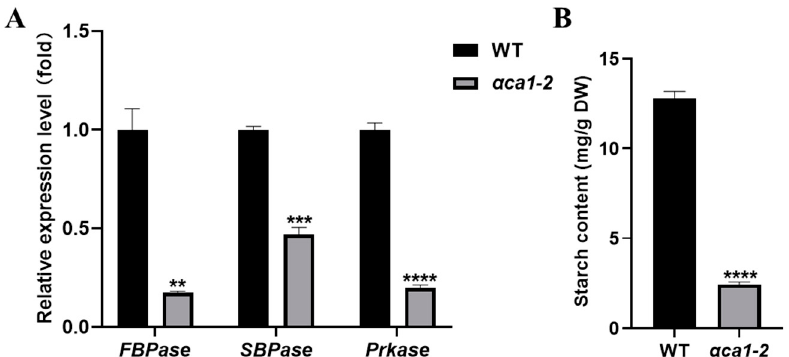
Figure 4. The degree of carbon assimilation was impaired in α ca1-2 . ( A ) The relative expression level of genes related to carbon assimilation. FBPase : Fructose-1,6-bisphosphatase; SBPase : Sedoheptulose-1,7-bisphosphatase; Prkase : 5-phosphate ribulose kinase. Ubiquitin was used as the control. ( B ). The starch content of flag leaves. DW: dry weight. All values are shown as means ± SEM determined via Student’s t -test, where ** p < 0.01, *** p < 0.001, **** p < 0.0001 and n ≥ 3.